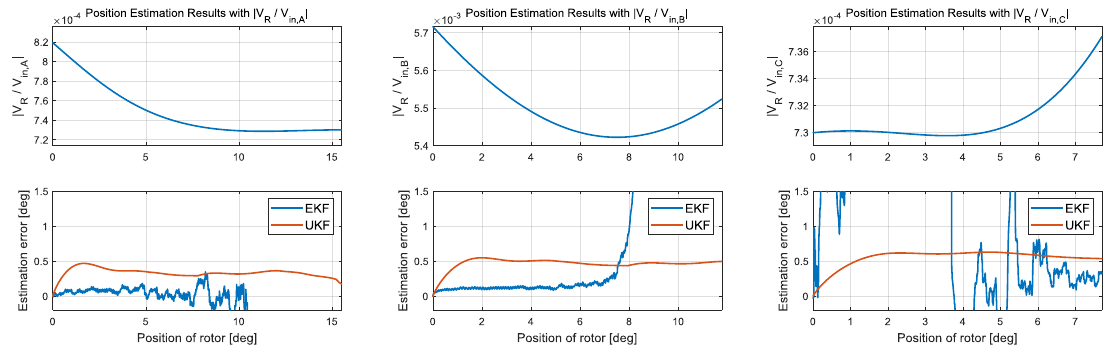
Figure 15. The results of position estimation comparing the EKF and UKF.